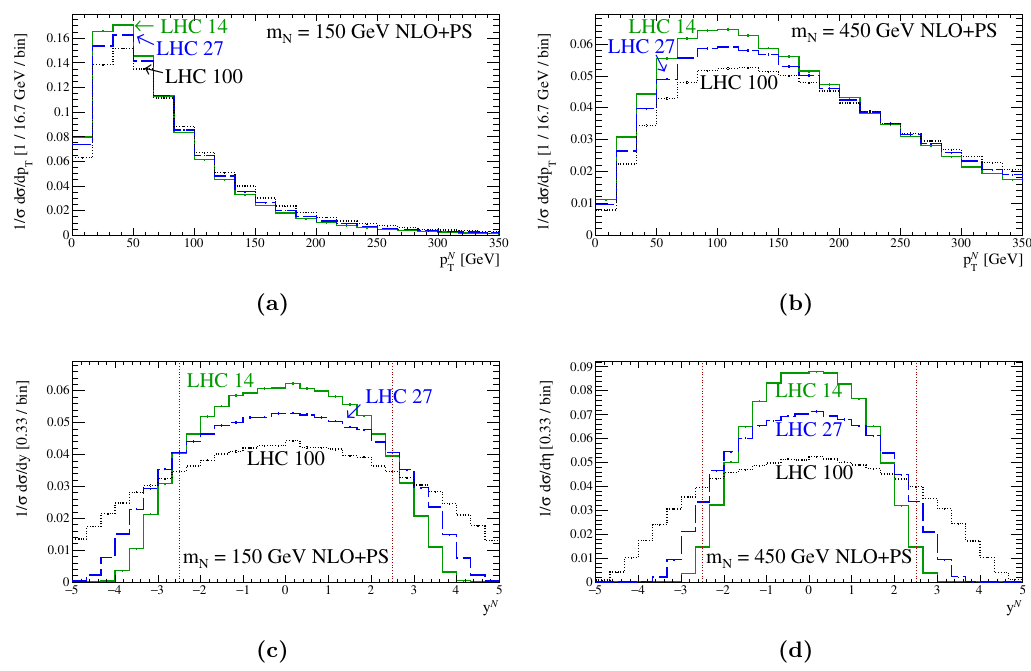
Figure 8. Same as (cid:12)gure 5 but at NLO+PS accuracy with particle-level reconstruction.